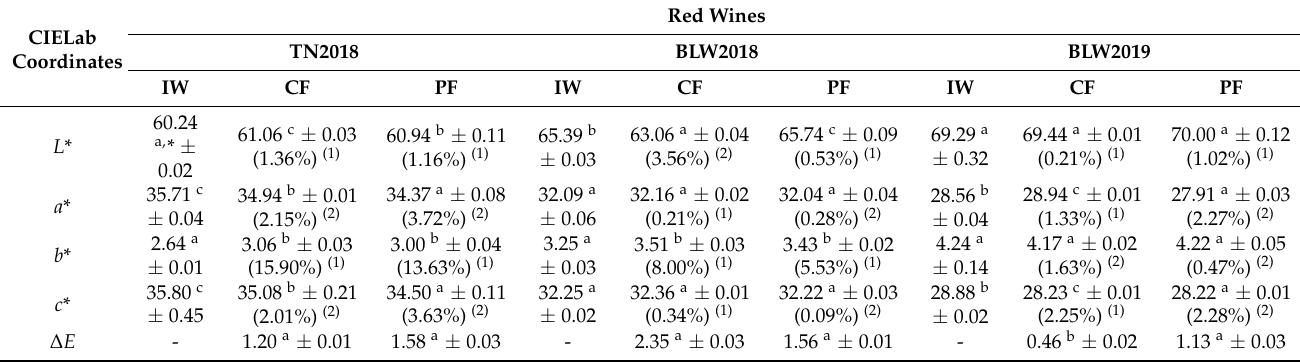
Table 2. The impact of the two different filtration techniques on chromatic characteristics using CIELab coordinates for the three red wines